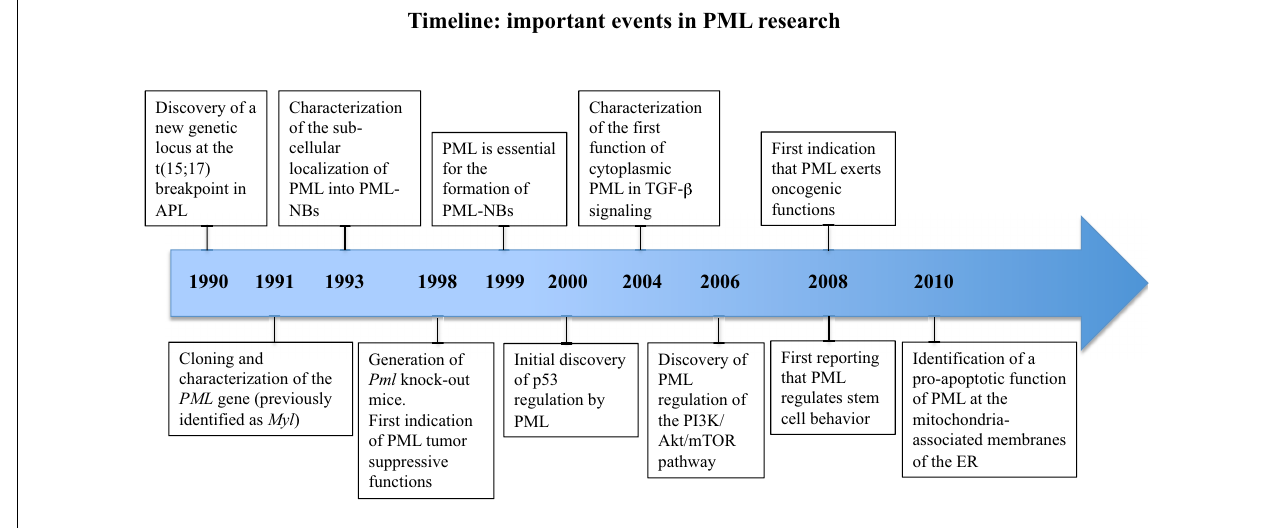
FIGURE 1 |Timeline of the milestone discoveries on PML